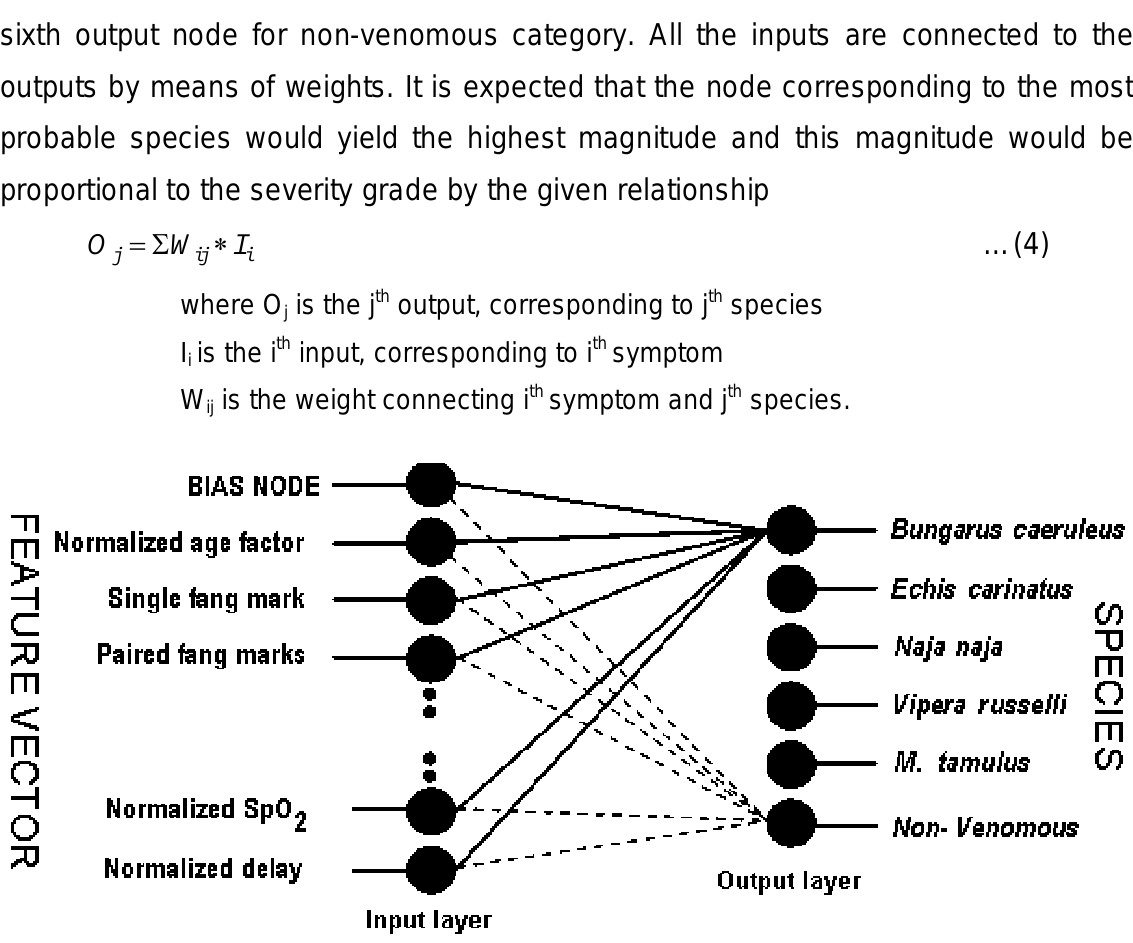
Figure 1: Neural network topology, feature vector as input and species as